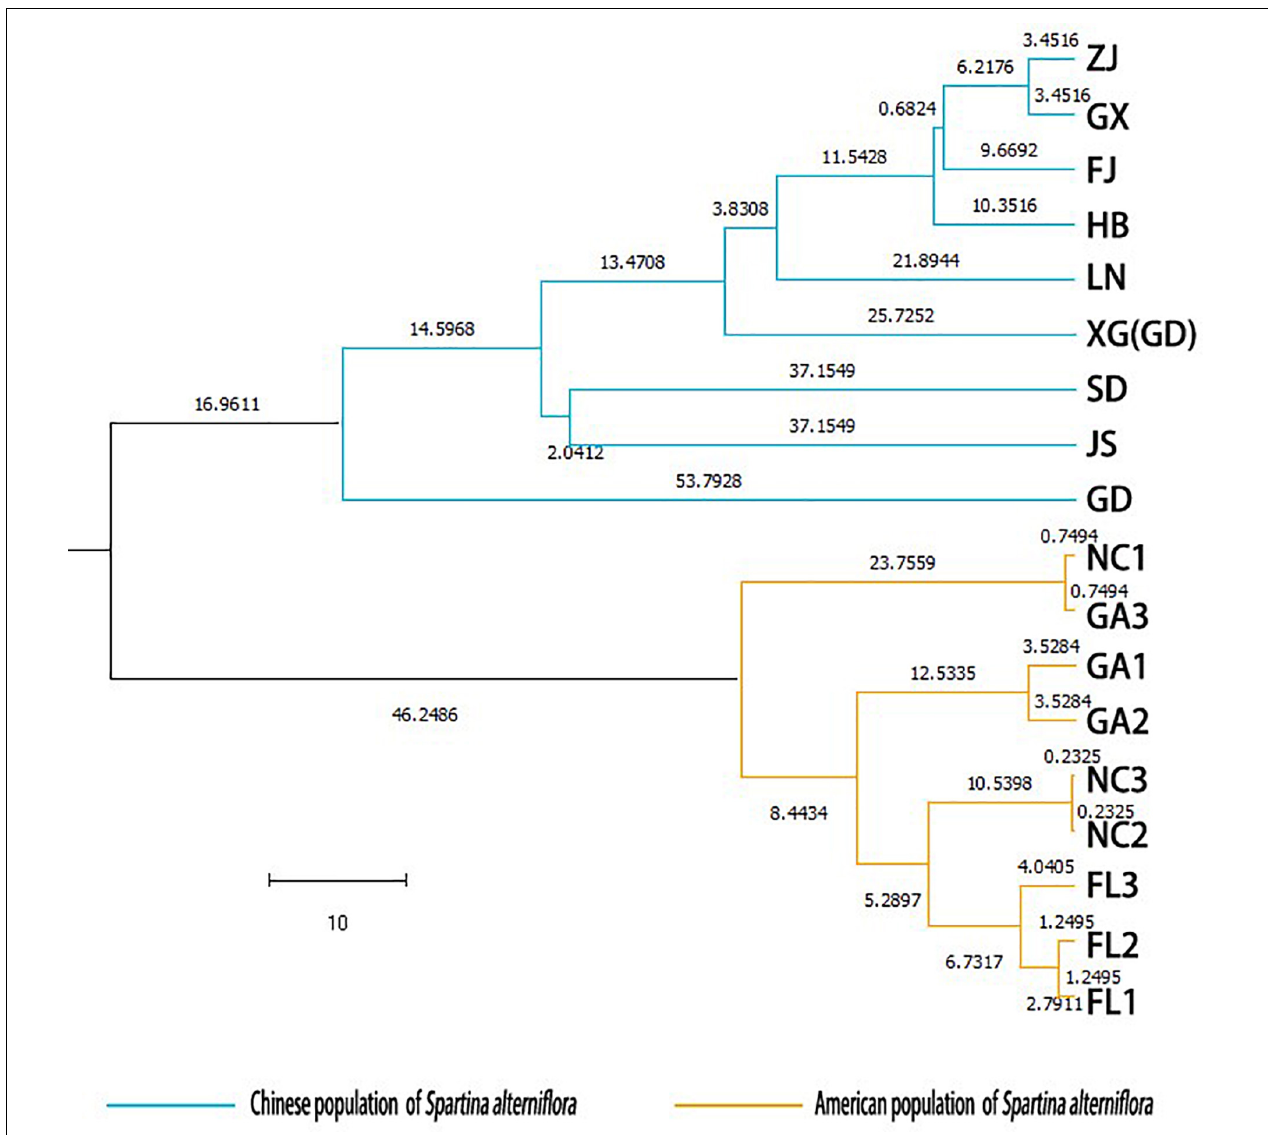
FIGURE 3 | Unweighted pair-group method with arithmetic average dendrogram based on Nei’s (1973) genetic distance among the populations of Spartina alterniflora.